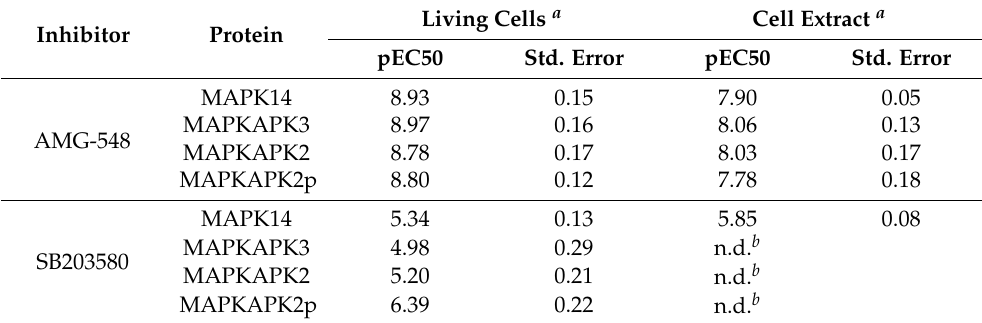
Figure 2. ITDR-CETSA experiments for a compound concentration range between 0.3 nM and 20 µM as well as without compound (only DMSO) at a constant treatment temperature of 51 °C. ( a ) Immunoblots for one of the replicates of ITDR-CETSA experiments for living cells and cell extract, respectively. ( b ) Dose–response curves (solid lines) derived from integrated, normalized, and fitted signal intensities from the immunoblots. Datapoints and error bars represent means over the four replicates (n = 4) +/ − one standard deviation. The fitted pEC50 values are summarized in Table 2. Data for ERK 11e are shown in Supplementary Figure S3. Table 2. Data of the ITDR-CETSA experiments shown in Figure